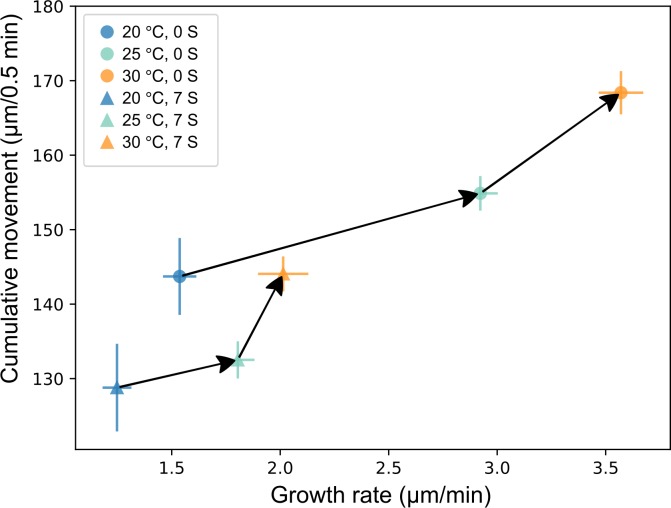
Movement and growth rate responses of E3 developmental–stage R. balthica(n = 277) exposed to combinations of temperature and salinity for a period of 24 h (means ± 1 SD, S4 Data).